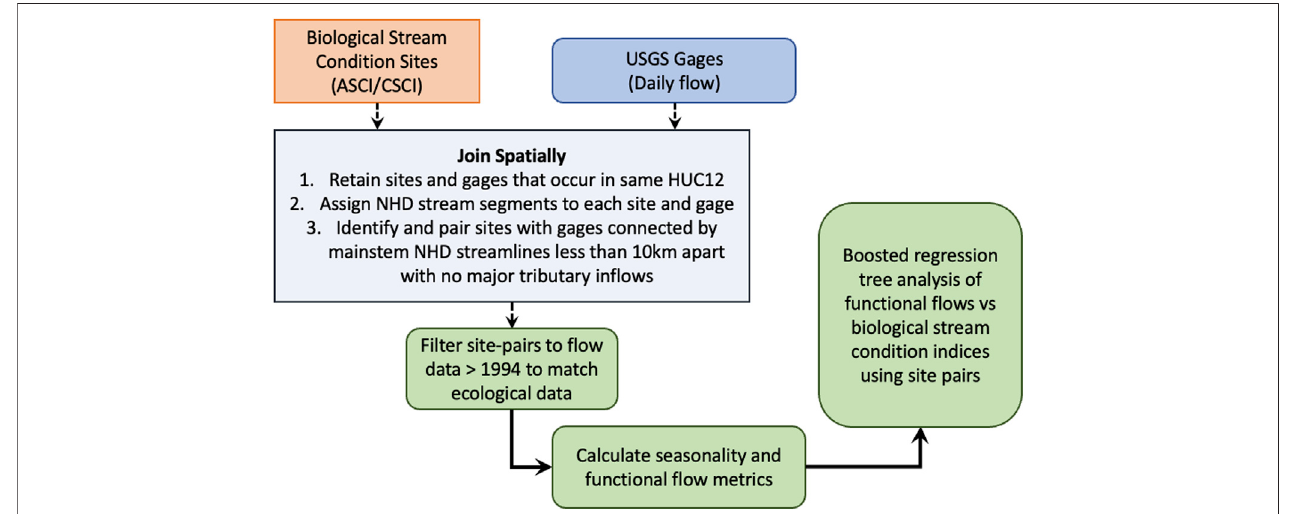
FIGURE 1 | Work fl ow diagram of steps used to pair biological stream condition sites with USGS gage